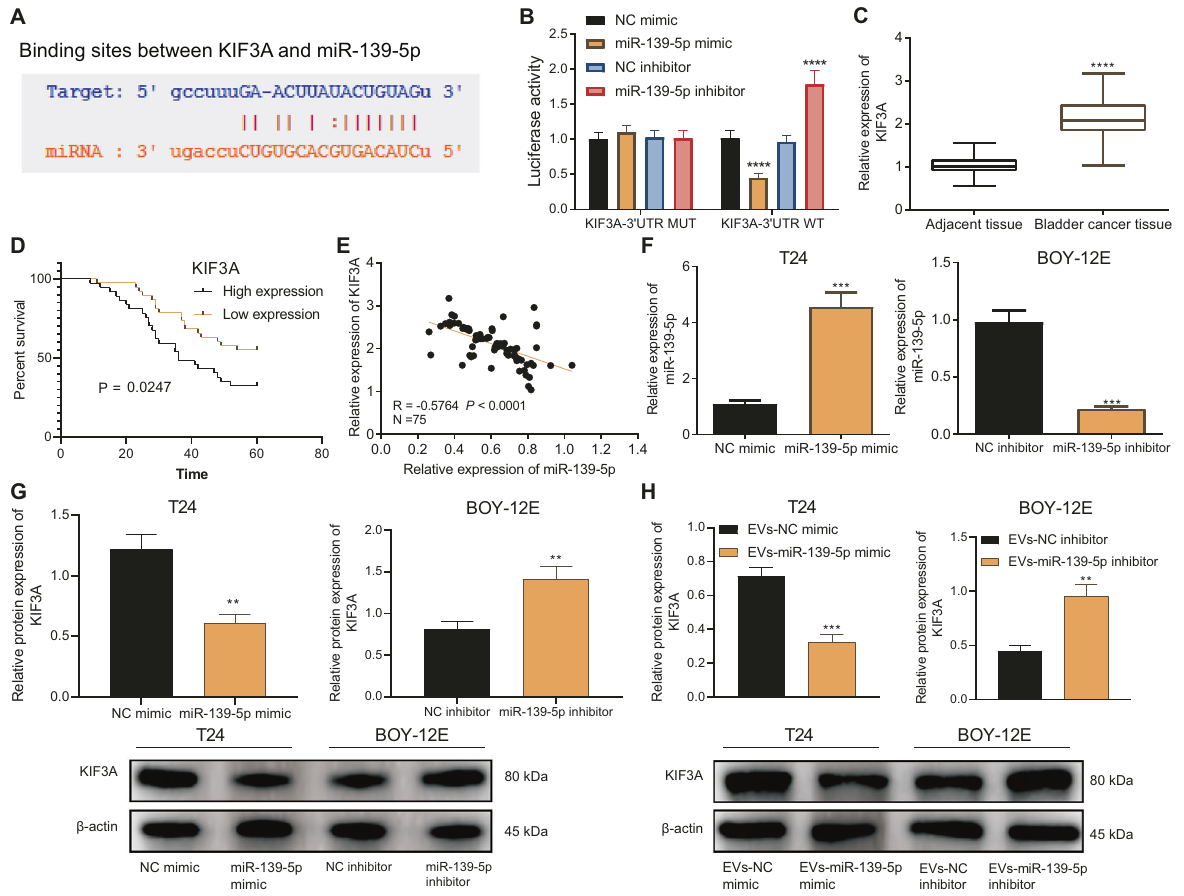
Fig. 4 miR-139-5p delivered by BMSCs-EVs targets KIF3A and inhibits KIF3A expression. A Binding sites between KIF3A and miR-139-5p predicted by the starBase and miRDB databases. B Binding of miR-139-5p to KIF3A veri fi ed using dual-luciferase reporter assay. **** p < 0.0001, vs. NC mimic or NC inhibitor. C The expression of KIF3A in bladder cancer tissues and adjacent normal tissues detected using RT-qPCR ( n = 75). **** p < 0.0001, vs. adjacent normal tissues. D The relationship between the survival rate of patients with bladder cancer and KIF3A expression analyzed by the Kaplan – Meier method ( n = 75). E Correlation between miR-139-5p expression and KIF3A expression in cancer tissues of patients with bladder cancer ( n = 75) analyzed by Pearson ’ s correlation coef fi cient. F The expression of miR-139-5p in T24 cells transfected with miR-139-5p mimic and BOY-12E cells transfected with miR-139-5p inhibitor detected by RT-qPCR. G The expression of KIF3A in T24 cells transfected with miR-139-5p mimic and BOY-12E cells transfected with miR-139-5p inhibitor detected by western blot analysis. In panels ( F , G ), ** p < 0.01 or *** p < 0.001 vs. NC mimic or NC inhibitor. H KIF3A expression in T24 cells co-cultured with EVs-miR-139-5p mimic and BOY-12E cells co-cultured with EVs-miR-139-5p inhibitor tested by western blot analysis. ** p < 0.01 or *** p < 0.001 vs. EVs-NC mimic or EVs-NC inhibitor. Measurement data were expressed as mean ± standard deviation. Paired t test was conducted to compare data between the cancer tissues and adjacent normal tissues. Unpaired t test was performed for two-group data comparison. The cell experiment was repeated three times